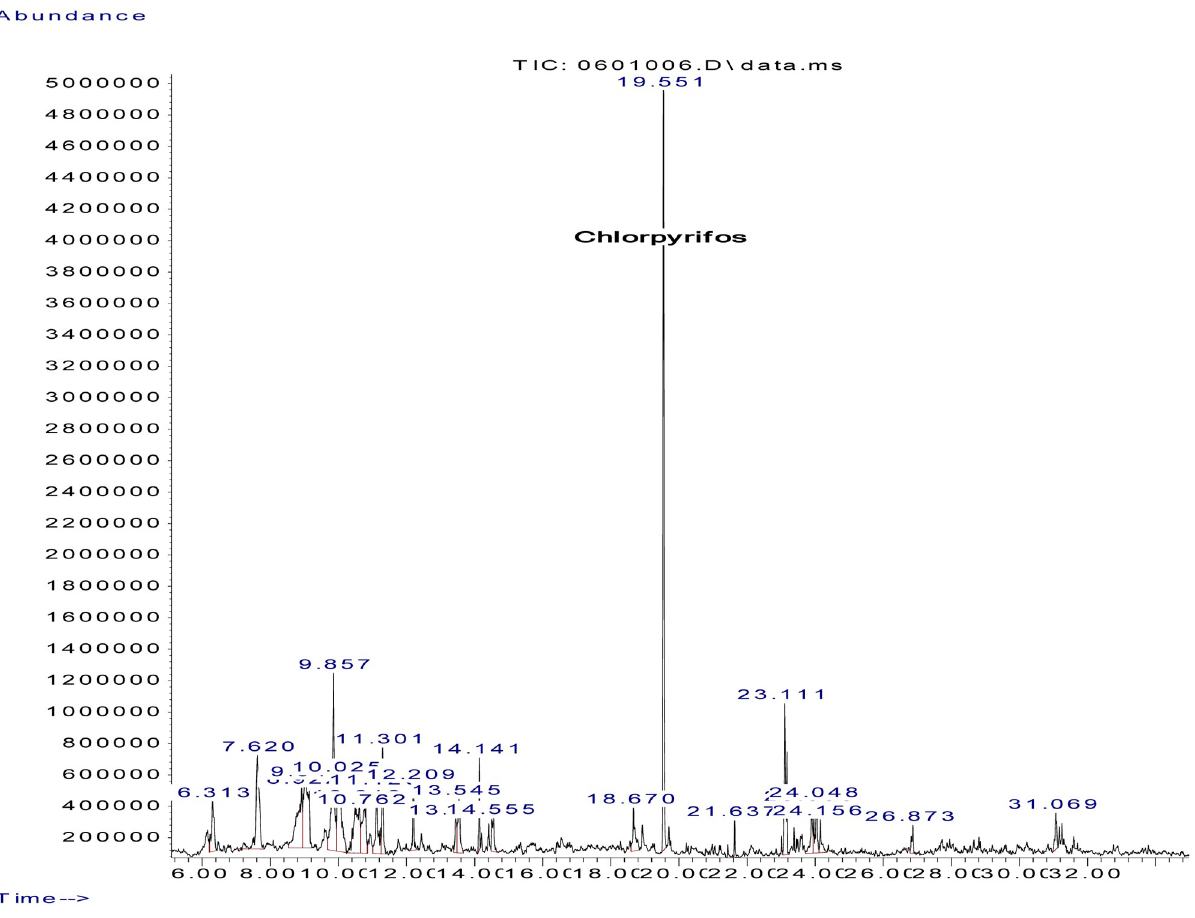
Fig 2. Chromatogram of chloropyrifos in watermelon.